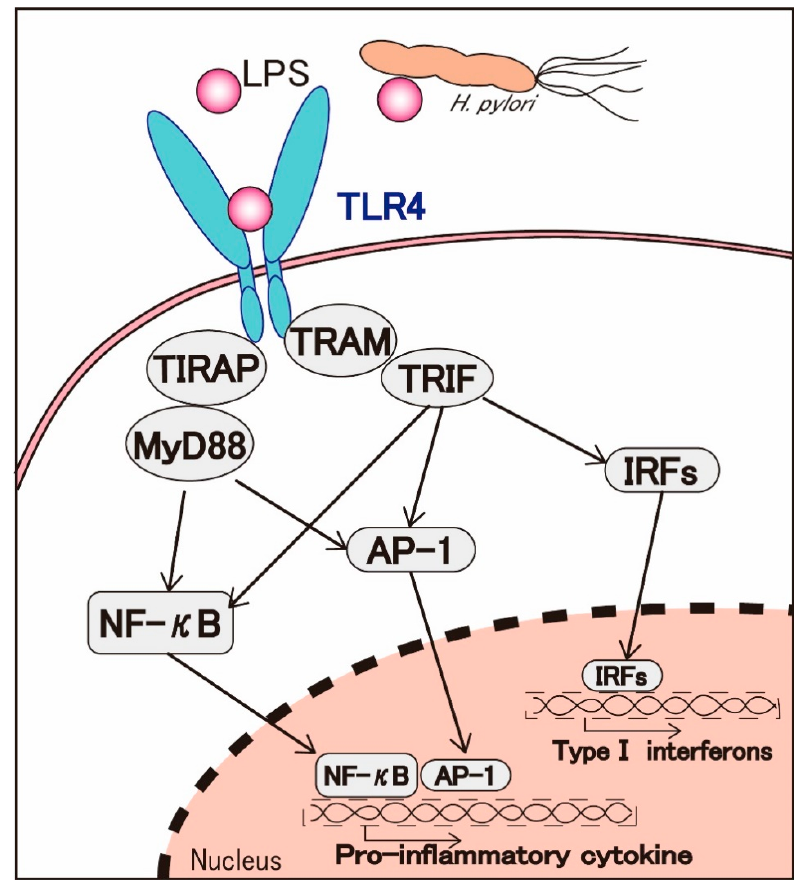
Figure 2. H. pylori LPS-mediated TLR4 signaling activation in gastric cancer. TLR4: toll-like receptor 4, TRAM: TRIF-related adaptor molecule, TIRAP: toll / interleukin-1 receptor (TIR) domain-containing adapter protein, TRIF: TIR domain-containing adapter inducing IFN- β , MyD88: myeloid differentiation factor 88, IRFs: interferon regulatory factors, NF- κ B: nuclear factor-kappa B, AP-1: activator protein